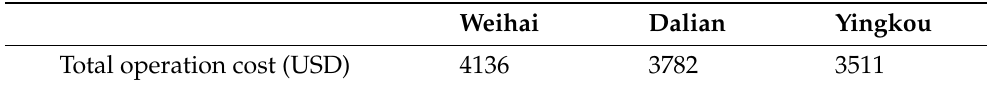
Table 5. Comparison of operating costs by locations.